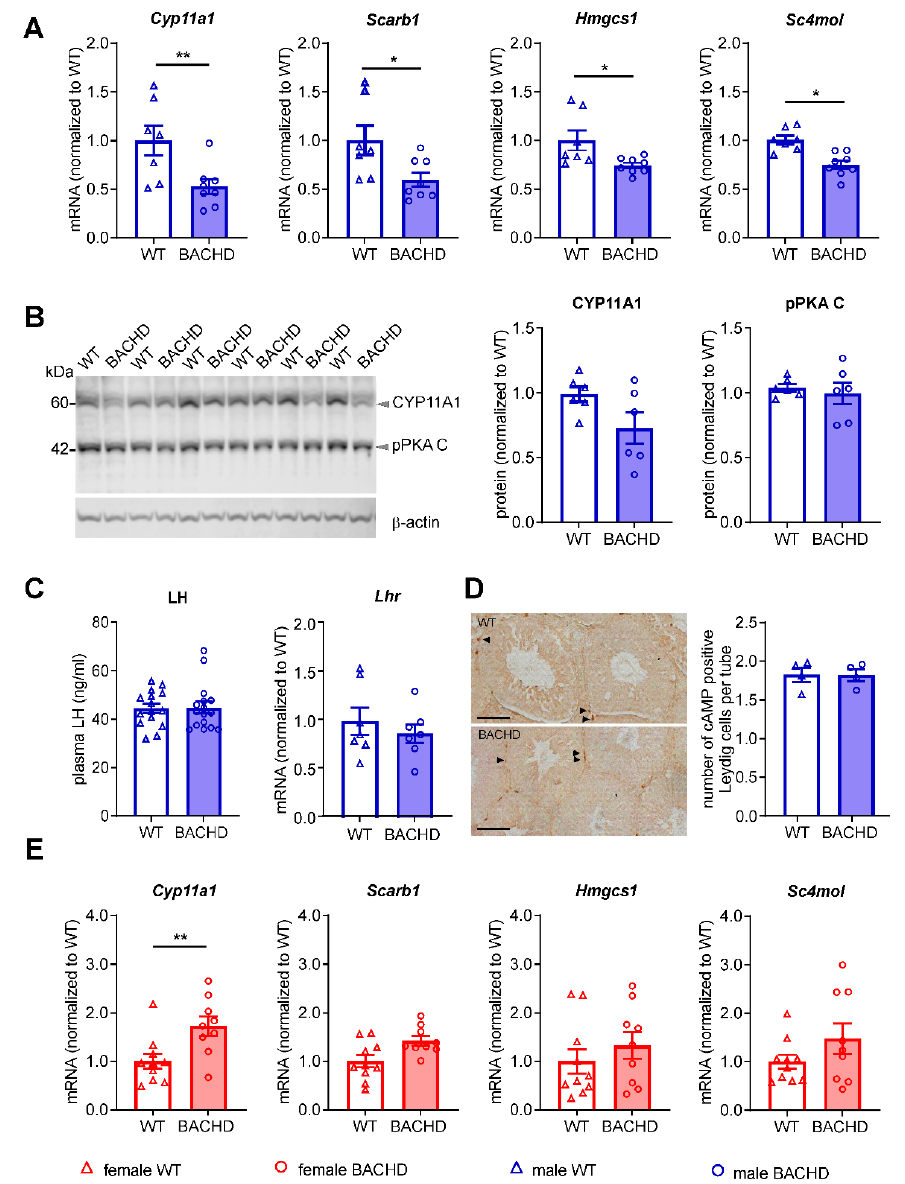
Figure 6. Downregulated expression of steroid biosynthesis-related genes in the testes but not ovaries of BACHD rats at 7 months of age and unchanged luteinizing hormone signaling. ( A ) mRNA expression levels of genes Cyp11a1 , Scarb1 , Hmgcs1 and Sc4mol in the testes ( n = 6–7 WT, n = 7–8 BACHD). ( B ) Representative western blot image, and quantification of protein expression levels of CYP11A1 and cAMP-activated catalytic subunit C of protein kinase A (pPKA C) in the testes ( n = 6/genotype). ( C ) Plasma luteinizing hormone (LH) levels ( n = 16/genotype) and mRNA expression levels of LH receptor ( Lhr ) ( n = 7/genotype). ( D ) Number of cAMP-positive Leydig cells in the testis of WT and BACHD rats ( n = 4/genotype) and representative images of anti-cAMP immunohistochemical staining (arrows in the images) in the testis of WT and BACHD rats ( n = 4/genotype). ( E ) mRNA expression levels of Cyp11a1 , Scarb1 , Hmgcs1 and Sc4mol in the ovaries ( n = 10 WT, n = 9 BACHD). Data are expressed as individual values and mean ± SEM; statistical significance was determined by Student’s t -test for all analyses. Data are expressed as mean values ± SEM. * p ≤ 0.05; ** p ≤ 0.01.